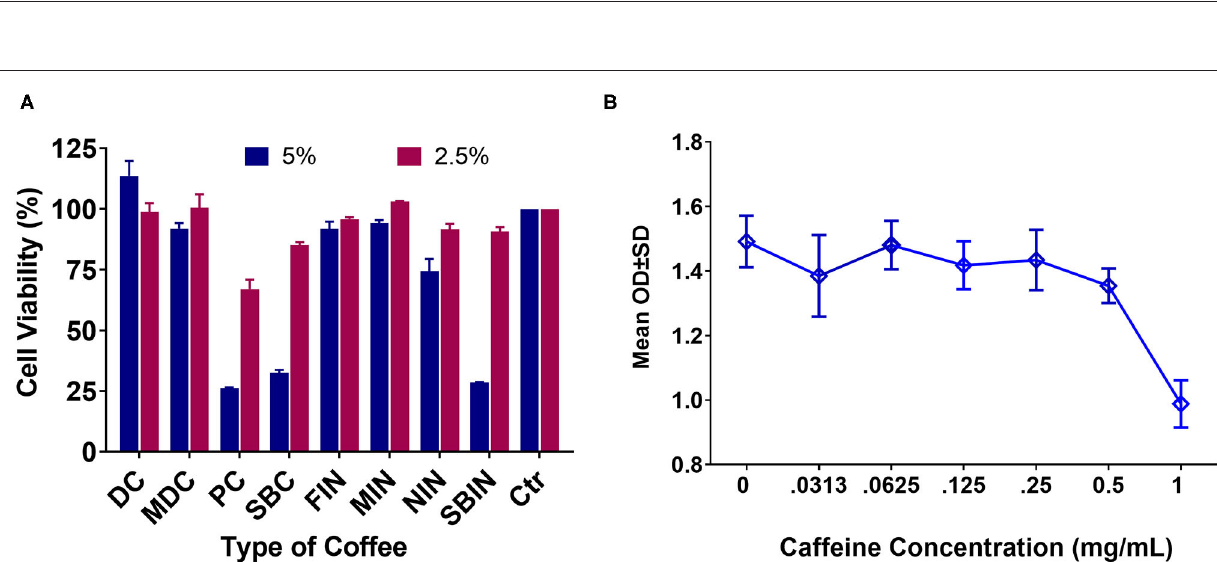
Frontiers in Nutrition | www.frontiersin.org